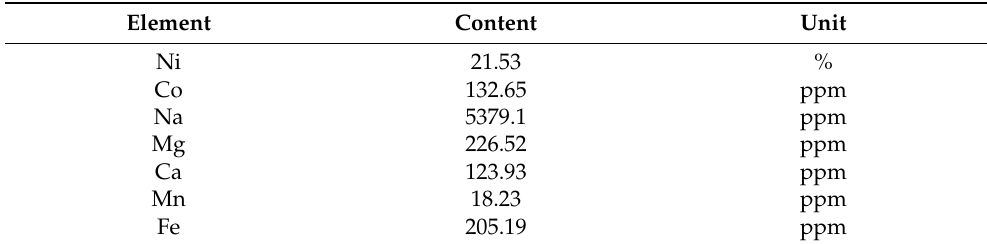
Table 2. The chemical composition of the synthesized nickel sulfate used as the source of nickel for the synthesis of NMC 811 cathode